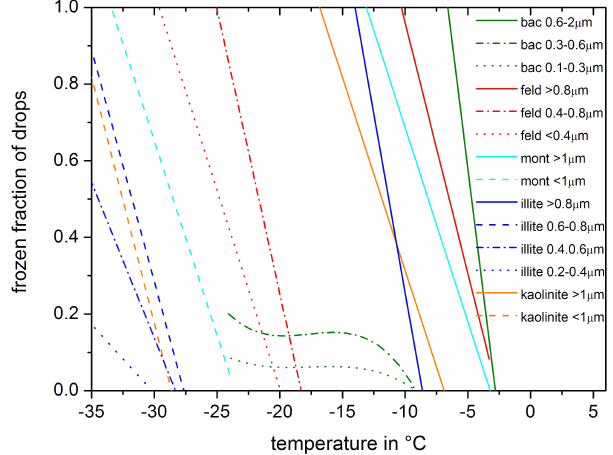
Figure 4. Frozen fraction of drops by contact freezing as a func- tion of temperature for various particle types and sizes, marked by different colors and line styles. Calculated by Eqs. (10) and (11), re- spectively, with constants given in Tables 2 and 3 for various particle types, based on the outcome of laboratory experiments (Pitter and